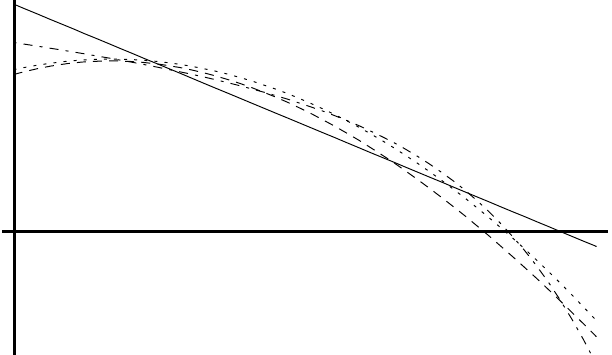
( C ) (dotted-dashed line), j